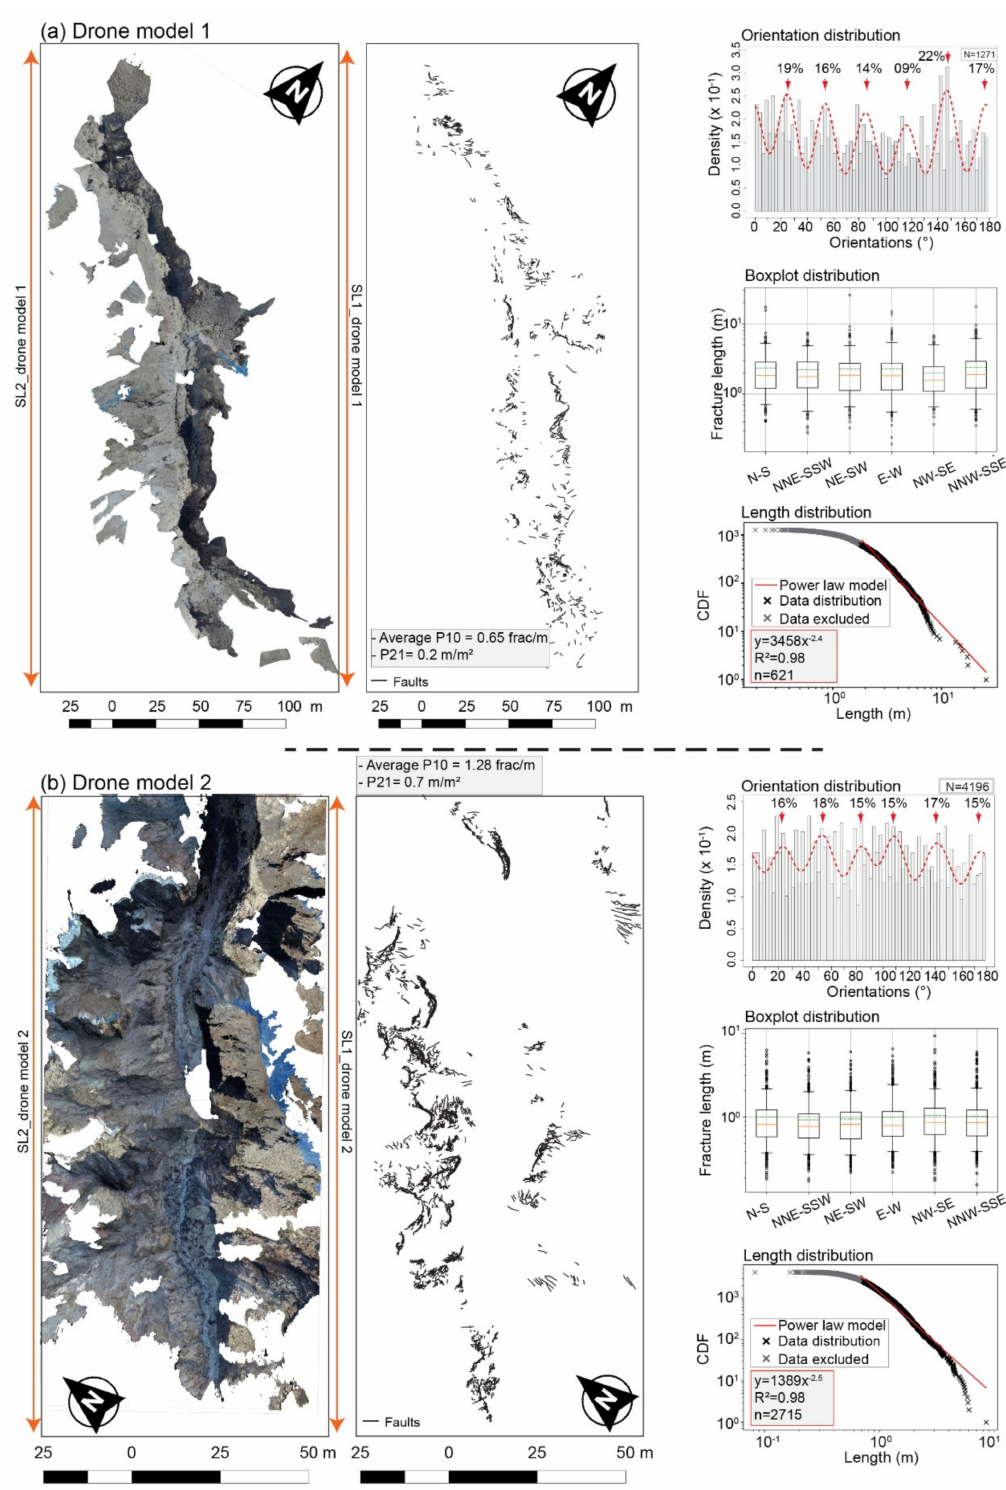
Figure 4. Fracture traces, orientation, boxplot length distributions from ( a ) drone model 1 and ( b ) drone model 2. Each fracture map data is expressed into histogram for orientation distribution, boxplot of length distribution according to the fracture orientations, and cumulative distribution function (CDF) of lengths. Two scanlines (SL) were taken along the left and the right side of the canyon. For the boxplots and orientation distributions legend, see Figure